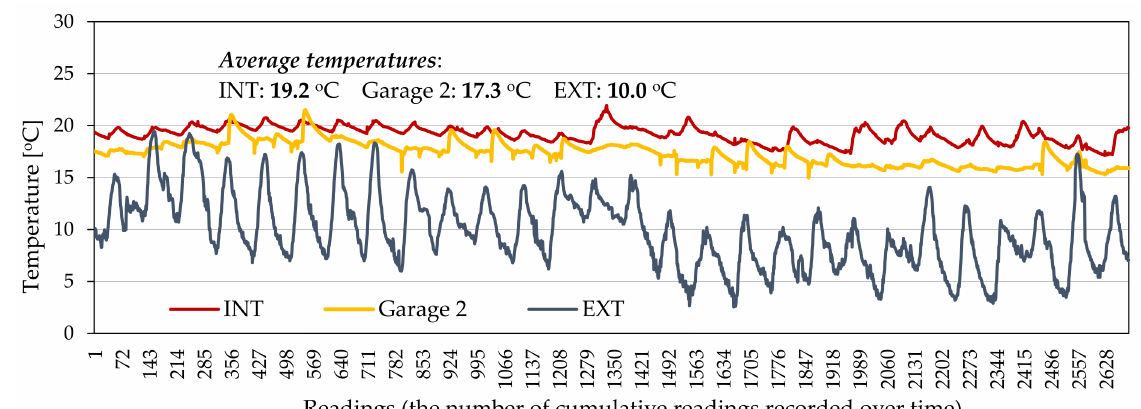
Figure 16. Global temperature profile in Garage